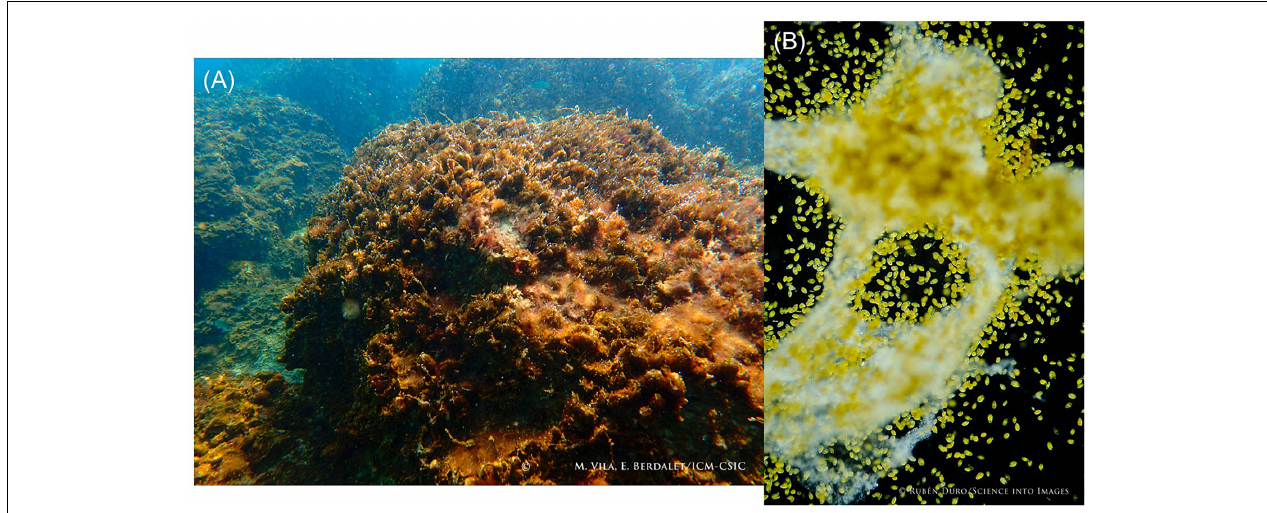
FIGURE 8 | Bloom of the benthic dinoflagellate Ostreopsis cf. ovata in the NW Mediterranean coast. (A) Mucilaginous biofilm covering the macroalgae (photo credit: M. Vila and E. Berdalet). (B) Microscopic image of Ostreopsis cells and the mucus produced to attach to the surfaces (magnification 4x) (photo credit: @RUBEN DURO/SCIENCE INTO